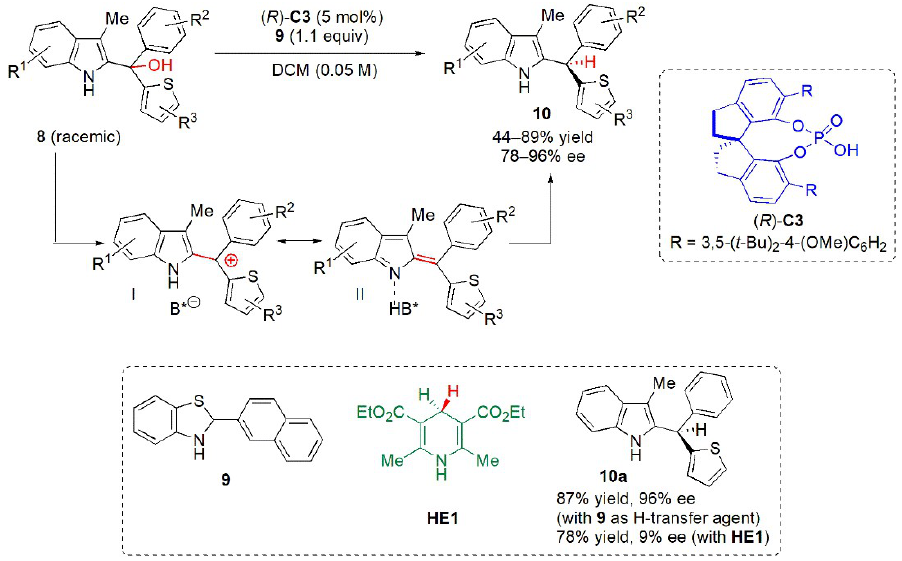
Figure 6. Enantioselective synthesis of bioactive indole-containing triarylmethanes [48]. B* = chiral acid counterion. acid